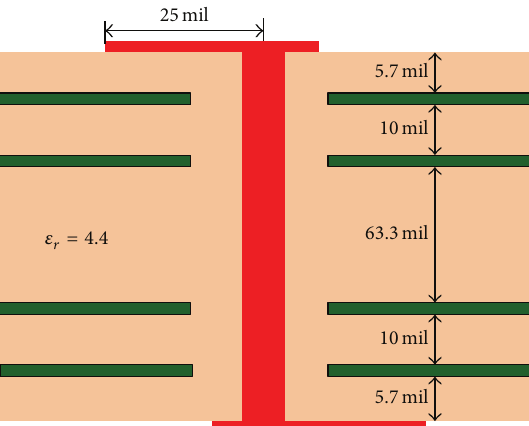
Figure 16: 𝑆 11 of a differential vias structure: (a) amplitude; (b) phase.